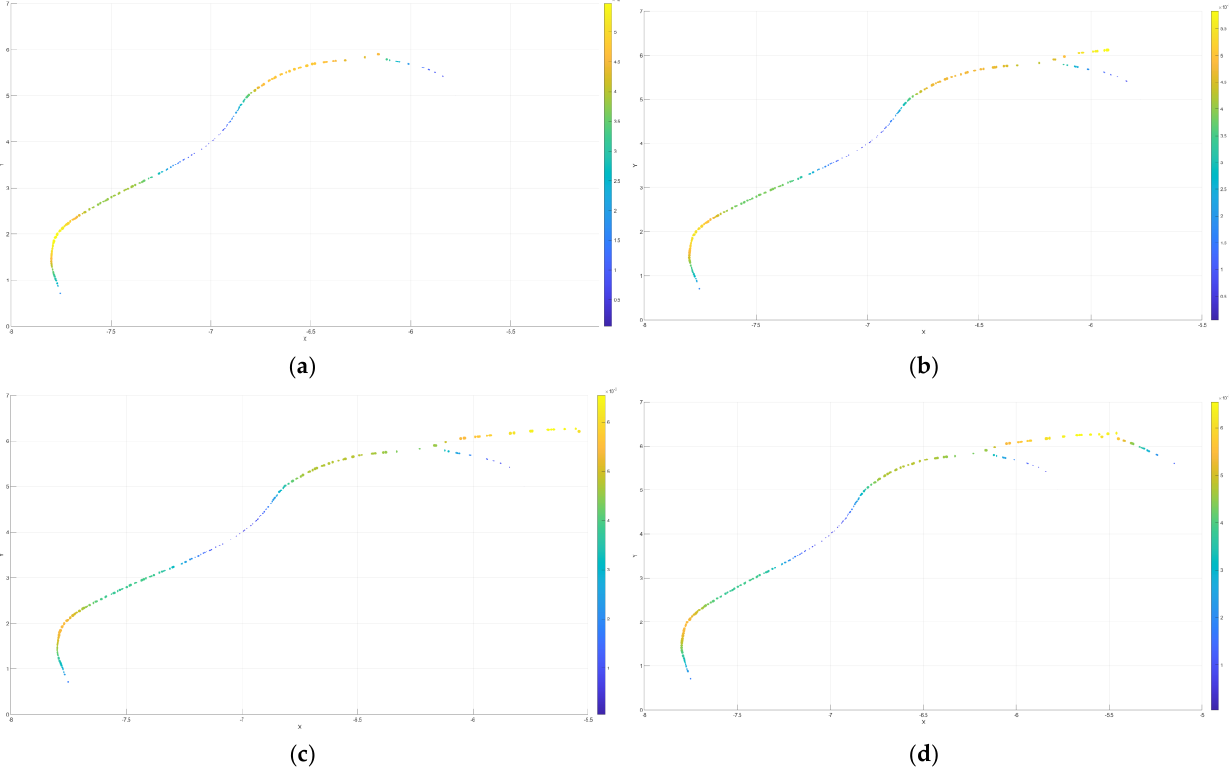
Figure 12. Only pioneering points exist. We use the branch points in the sample points to demonstrate the branch point addition process. There is only one branch in ( a ); ( b ) returns from the branch to the main worm path and continues; ( c ) continues in the direction of the main worm path; in ( d ) a second branch is generated.